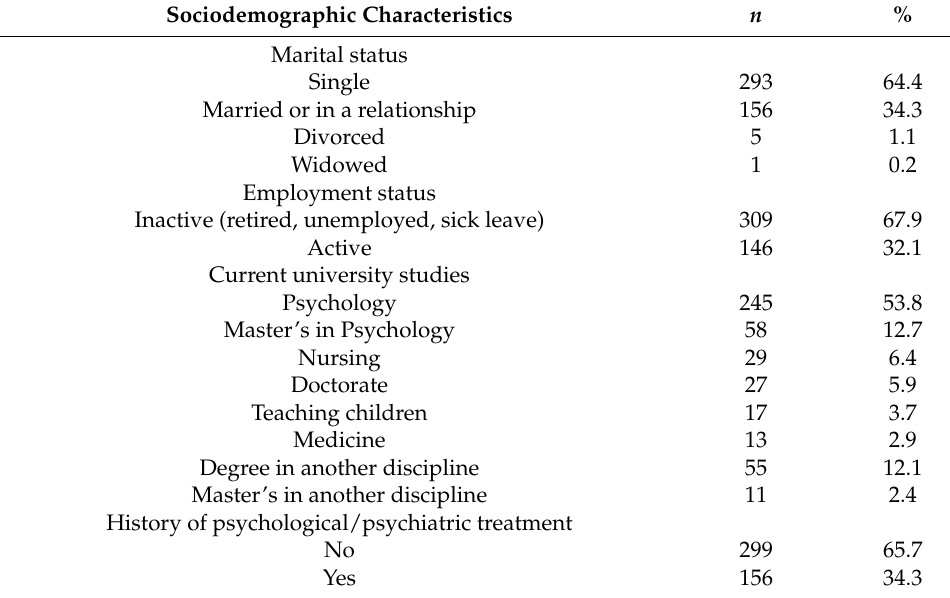
Table 1. Sociodemographic characteristics of the participants ( n =